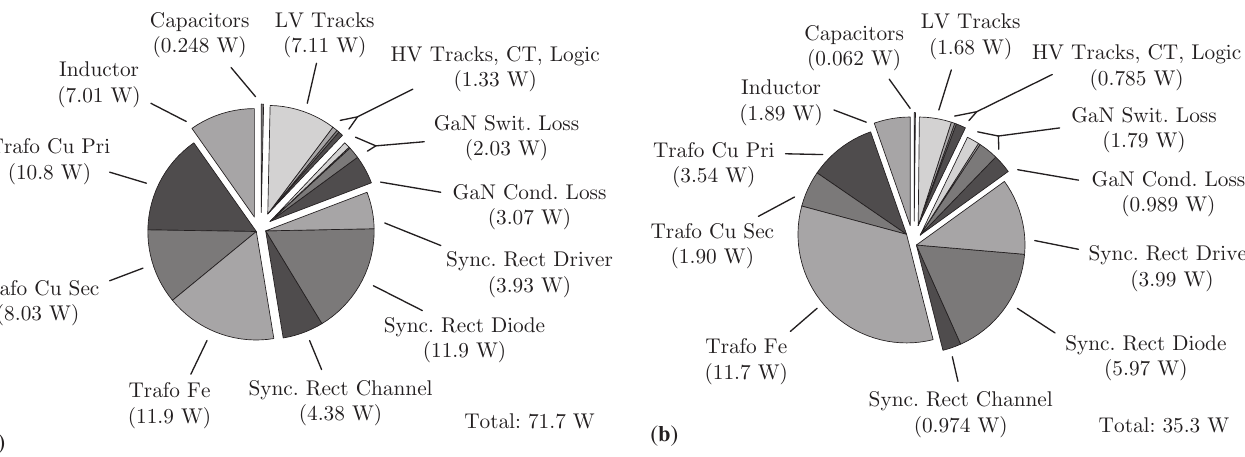
Figure 14. ( a ) Full- and ( b ) 50%-load loss budgets for the DC/DC converter with v dc = 400V and V o = 12V. Transformer, synchronous rectifiers and HV-side components/PCB tracks represent the three groups of loss contributors. Transformer losses accounts for 43% and 49% of the total losses at full and 50% load, respectively. Synchronous rectification is the second element with highest loss, achieving nearly 30% of the total losses in both load